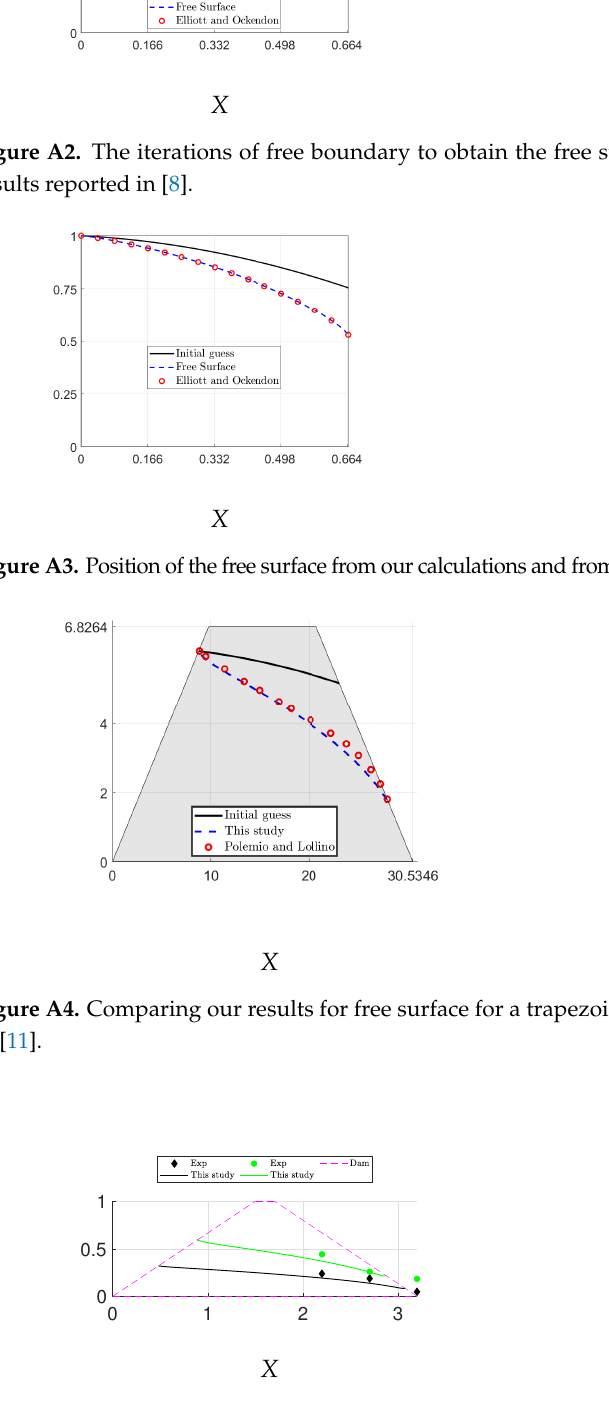
Figure A5. Validating our results for the free surface for a trapezoid dam with the experiments of